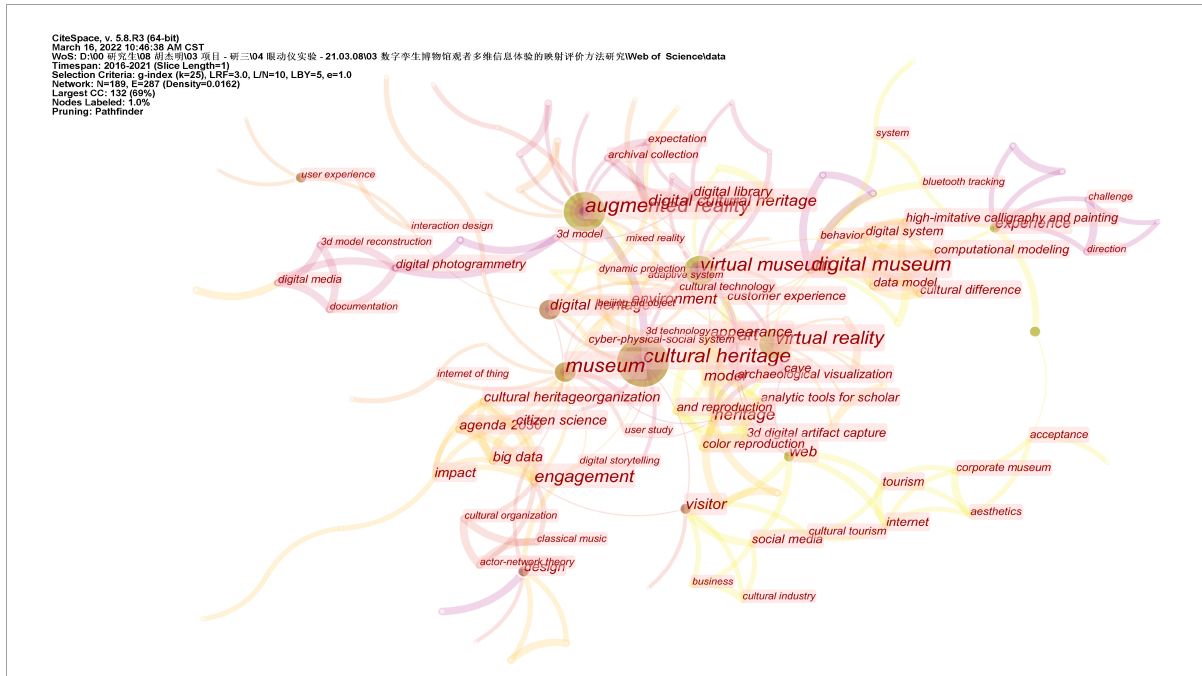
FIGURE2 Keyword o-occurrence network graph. Image source: The information was retrieved by our research team and exported after CiteSpace analysis. Data source: The authors were retrieved through Web of